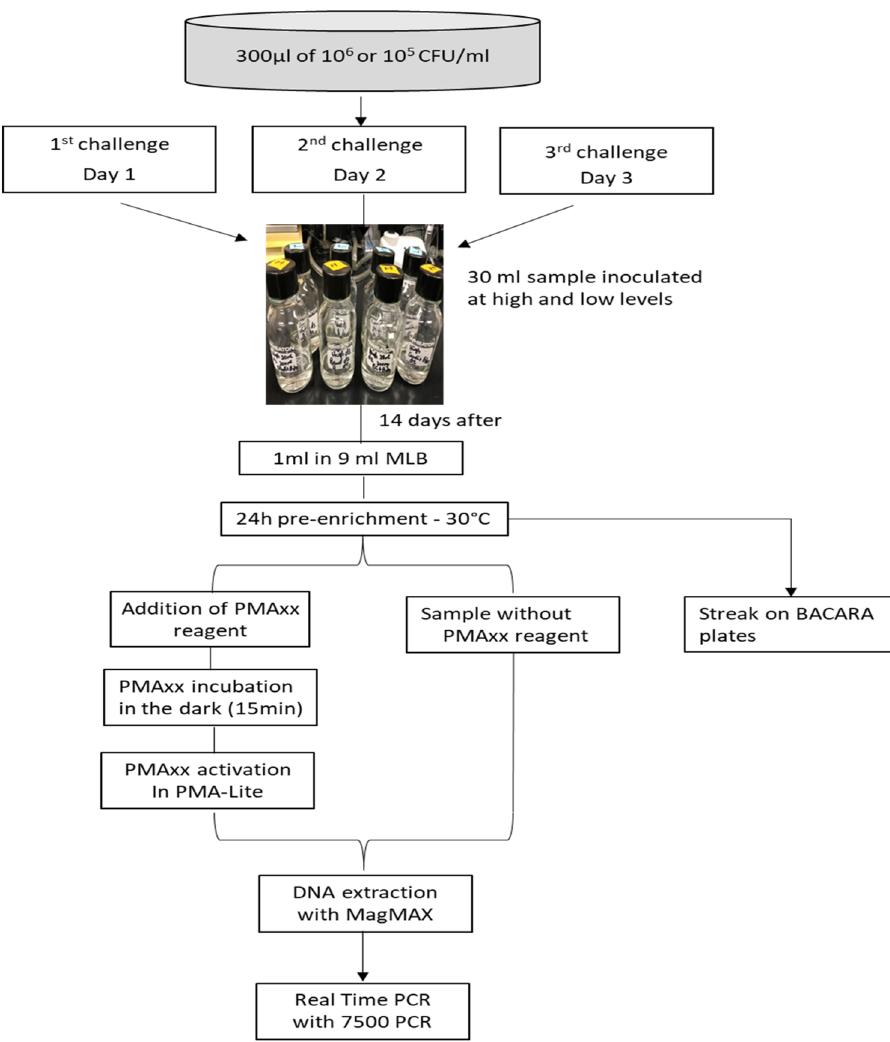
Figure 1. Overview of the workflow of the PMAxx-treated vs non-treated samples. MLB modified letheen broth, PMAxx modified propidium